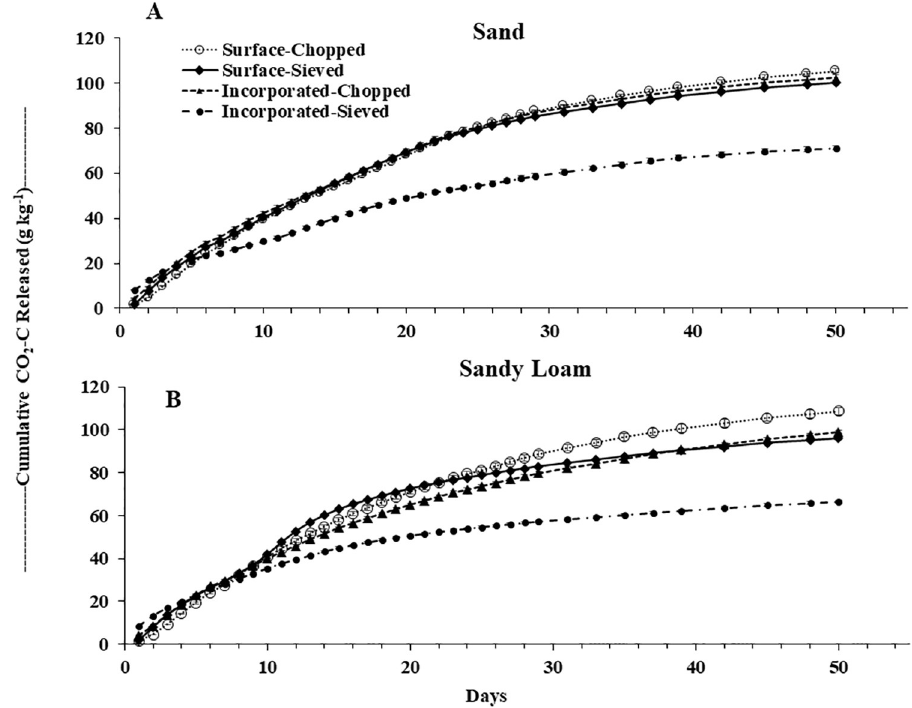
Fig 2. Amount of cumulative CO 2 -C released (rate as calculated per kg of residues) for barley residue decomposition under residue placement and residue size treatment combinations for A) sandy and B) sandy loam soils in 50-days’ laboratory incubation study at